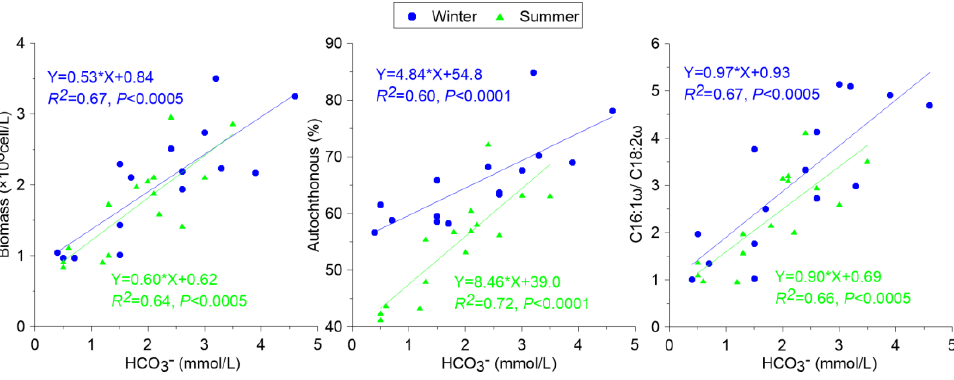
Figure 4. Relationship between photosynthesis and carbon weathering.